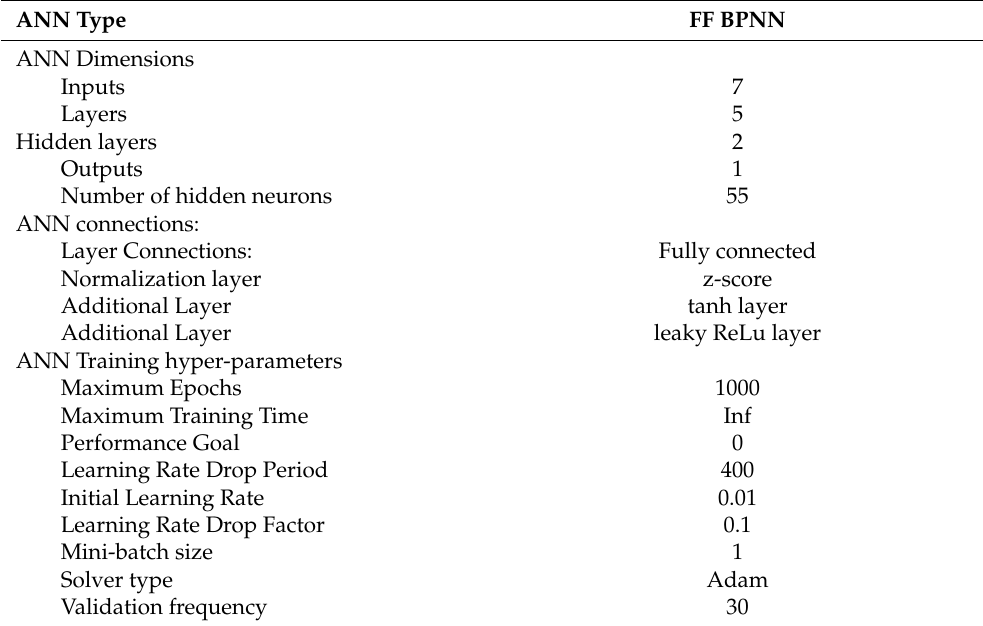
Table 2. Design parameters of the deep BPNN, along with the hyper-parameter values related to the training